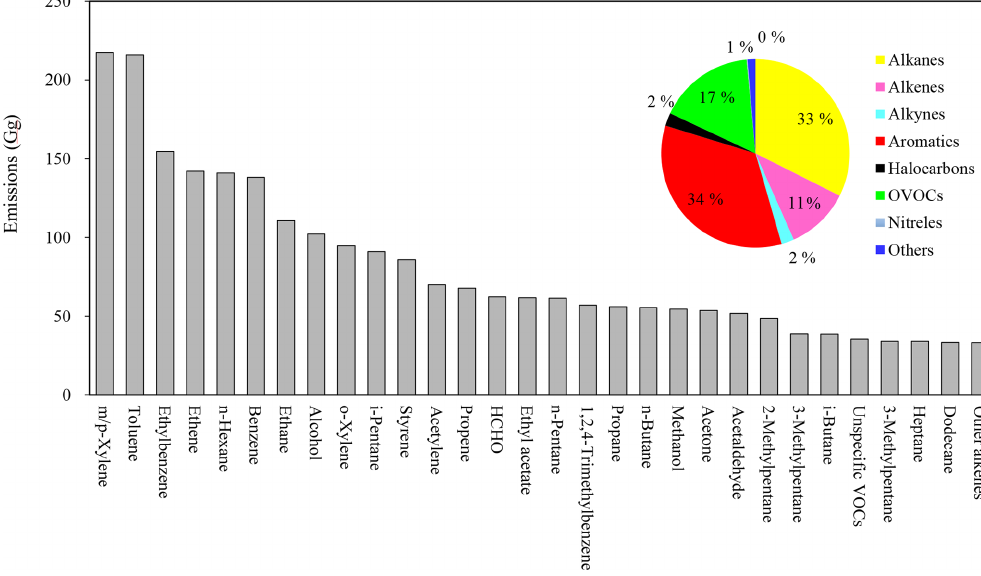
Figure 4. The top 30 VOC species with the highest emissions (bar graph) and the contributions of VOC groups to the total emissions (pie graph) in the BTH region, China.